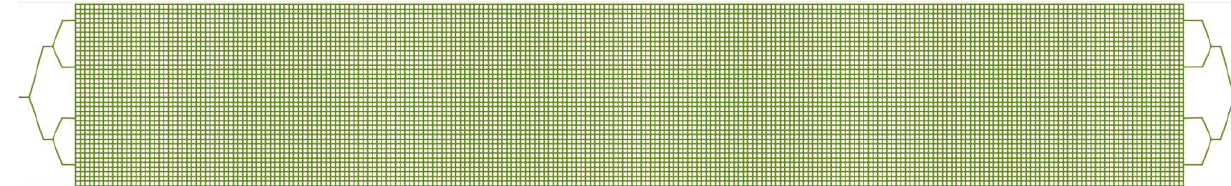
Figure 12. Network model of the Dolomite microchip: 3200284.